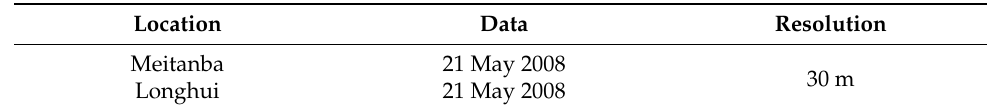
Table 1. Landsat5 images used in the study.